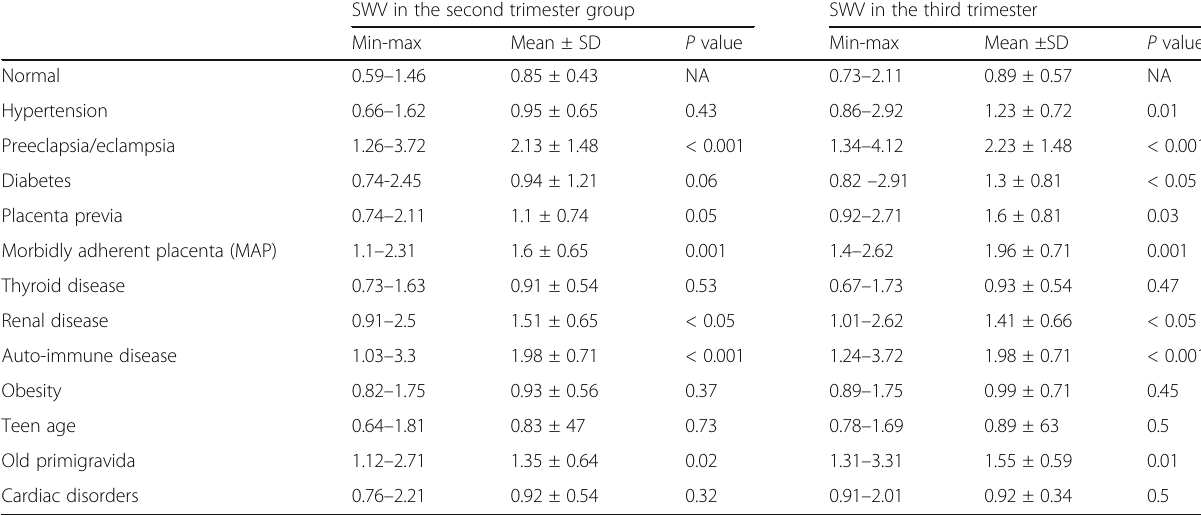
Table 2 Comparison of VTQ (SWV) in the second and third trimester pregnancies in normal and high-risk pregnancies SWV in the second trimester